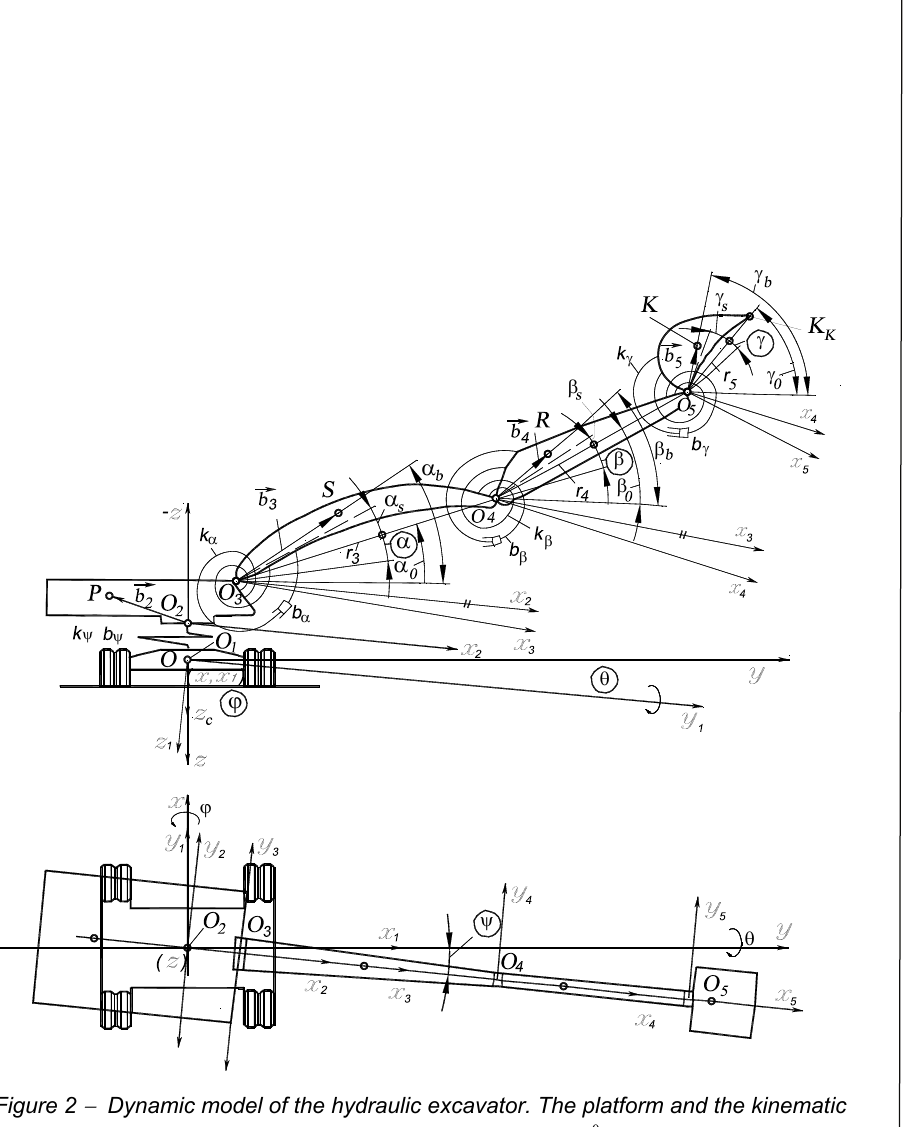
Figure 2  Dynamic model of the hydraulic excavator. The platform and the kinematic chain have been rotated by 0 90